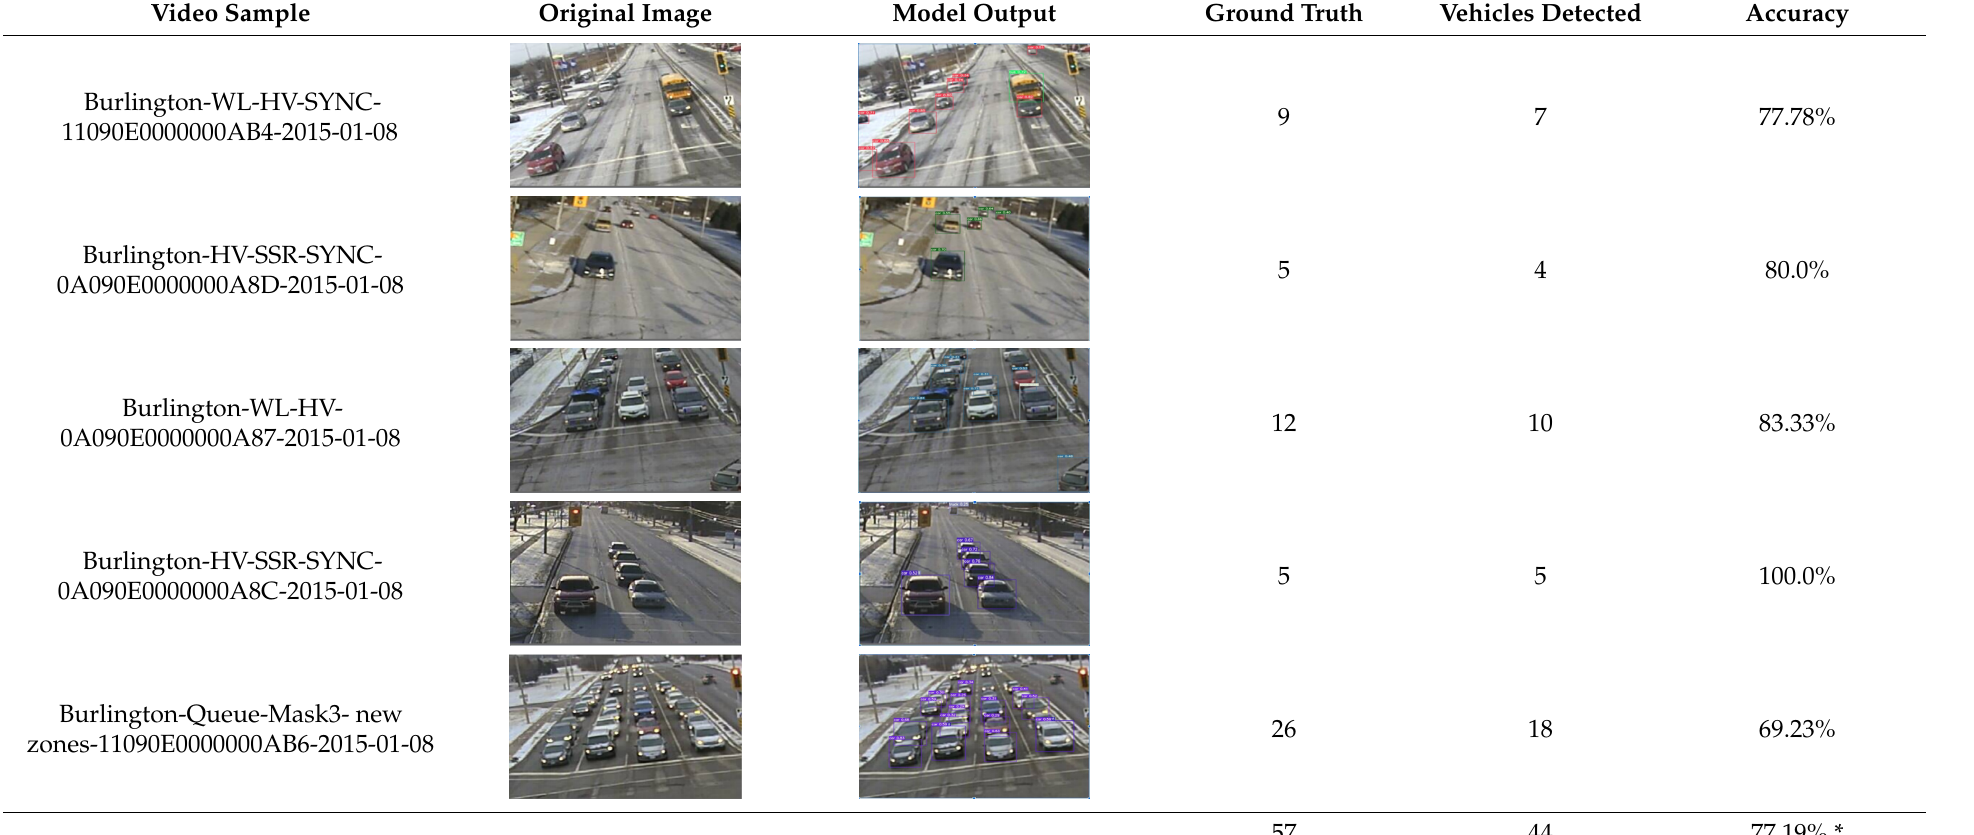
Table A4. Vehicle detection accuracies on selected images obtained from Burlington video using YOLOv4. Cars and buses marked as red/green/blue/purple and light green colors